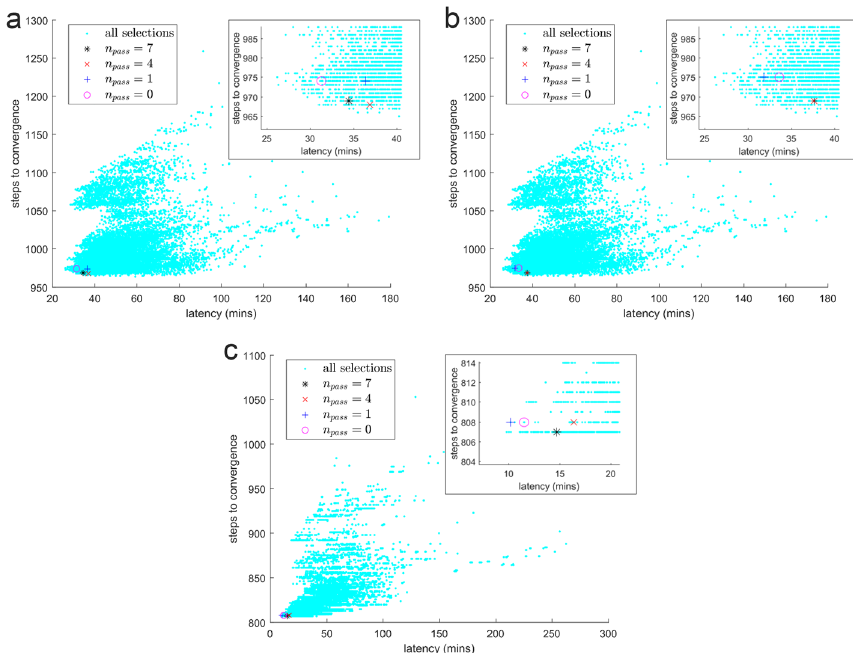
Fig. 1 For the global targets scenario in a and b and the Caribbean targets scenario in c , the performance of all possible combinations of 5 ground stations (out of 20 possible options) are shown in terms of latency and steps to convergence (fewer steps represents superior target coverage). Optimised selections overlay these results for varying values of n pass . In a and c selections are identified from all 20 ground station options,